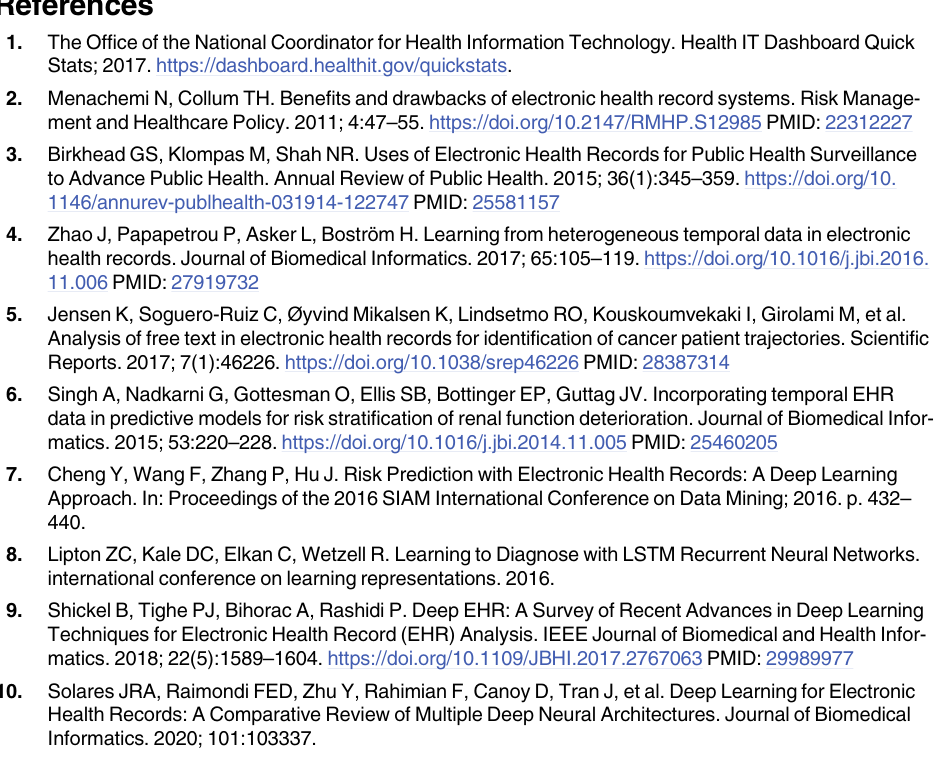
S3 Table. Modular vs end-to-end